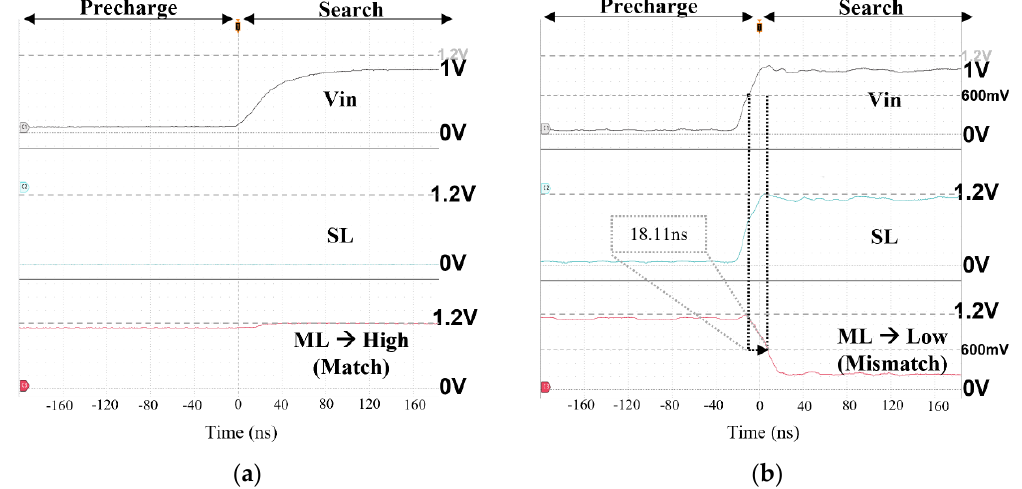
Figure 18. Timing waveforms confirmed by oscilloscope of 1 × 1 NEM-based CAM, where a ‘ 0 ’ value is written when searching. ( a ) ‘ 0 ’ results in a match and ( b ) ‘ 1 ’ results in a mismatch.